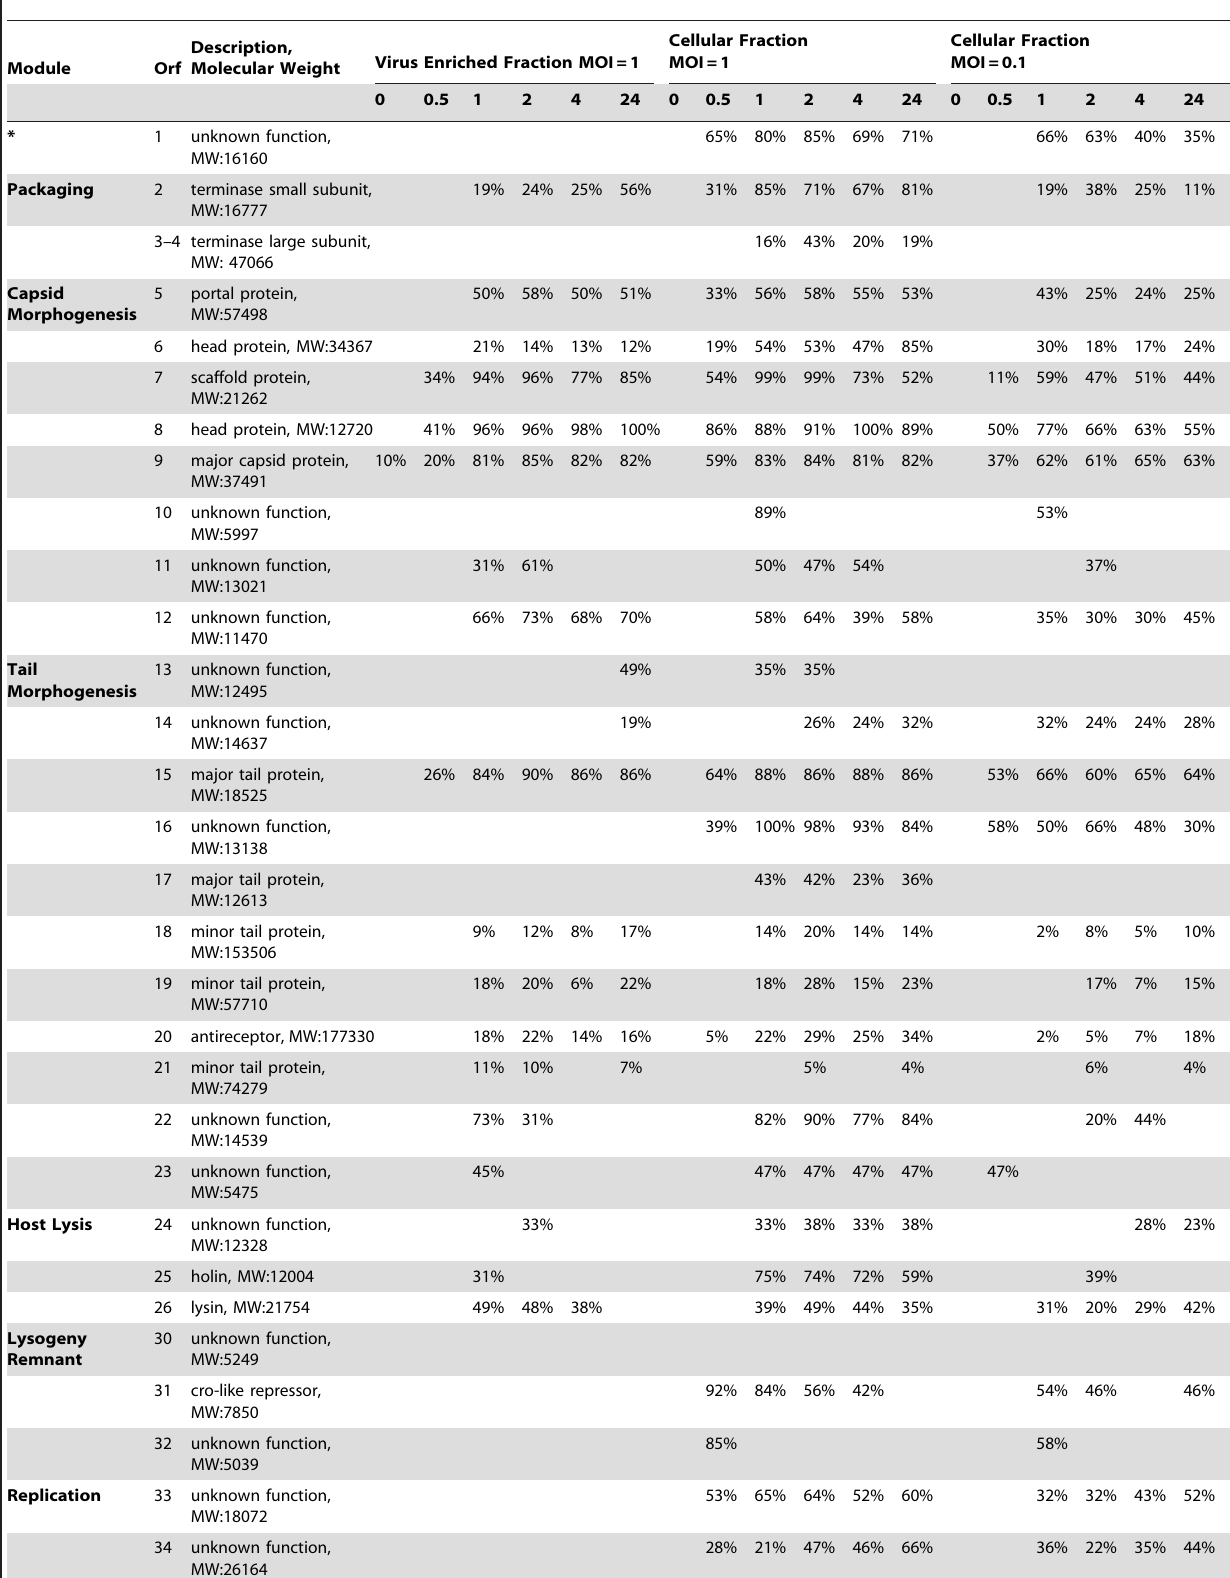
Table 2. Sequence coverages of phage 2972 proteins from virus-enriched and cellular fractions across infection time points.